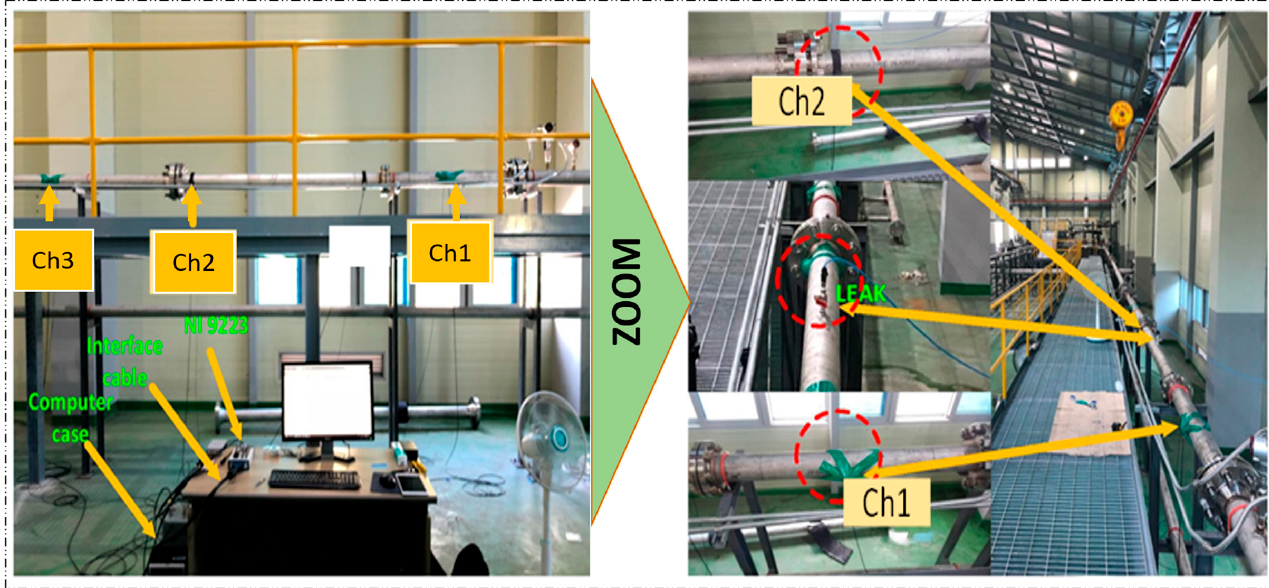
Figure 5. Experimental setup for sensor placement, leakage inducement, and data acquisition.